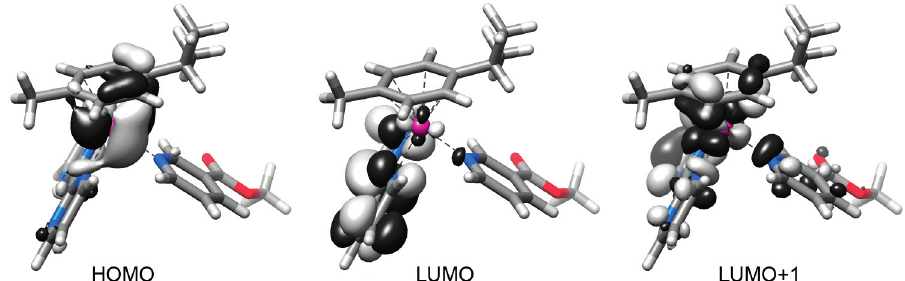
Figure 3. Selected frontier orbitals for complex 1 in the ground state (S0)